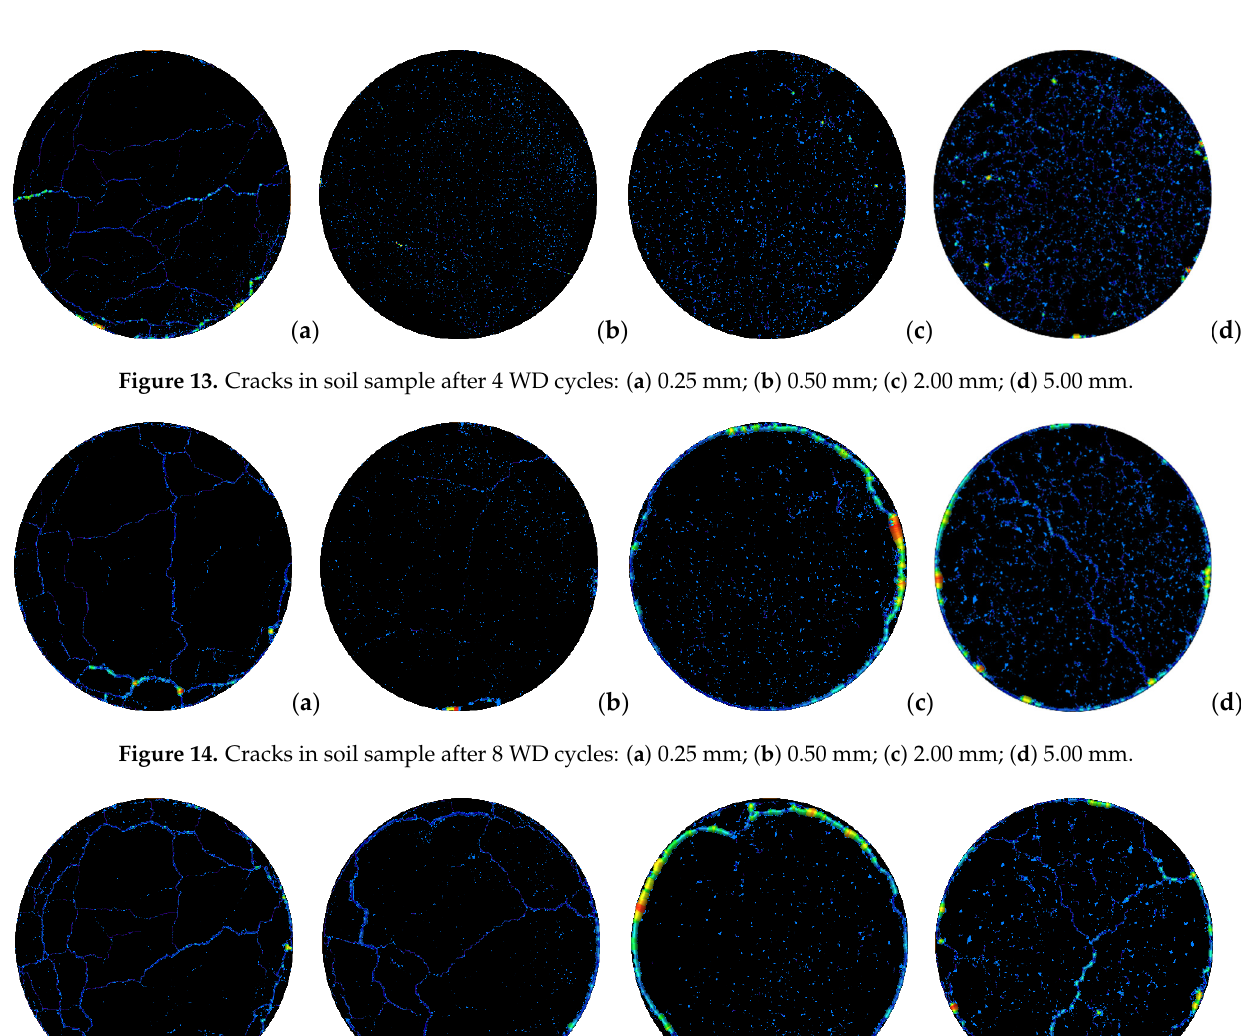
Figure 12. Cracks in soil sample after 1 WD cycle; ( a ) 0.25 mm; ( b ) 0.50 mm; ( c ) 2.00 mm; ( d ) 5.00 mm.